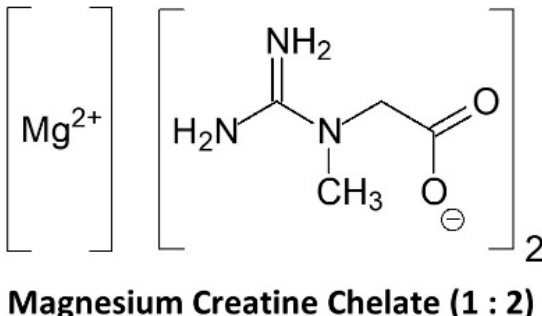
Figure 7. Chemical structure of magnesium creatine.